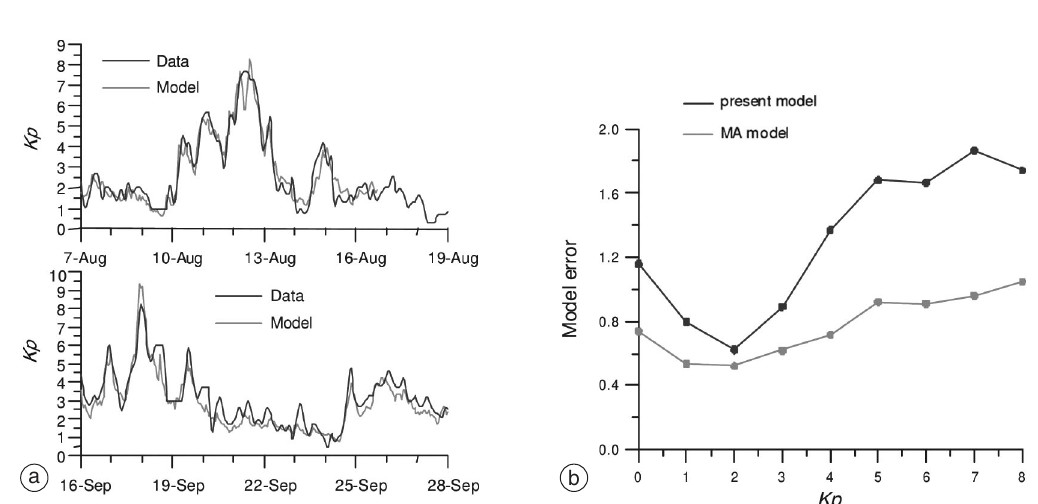
Fig. 3.12a,b. Performance of the Kutiev model of Kp : plot (a) actual and modelled Kp values for 7-19 August 200 and 16-28 September 2000; plot (b) the RMS error of the Kp and the Muhtarov-Andonov model, calculat- ed using ACE data covering 1998-2000 and binned by Kp